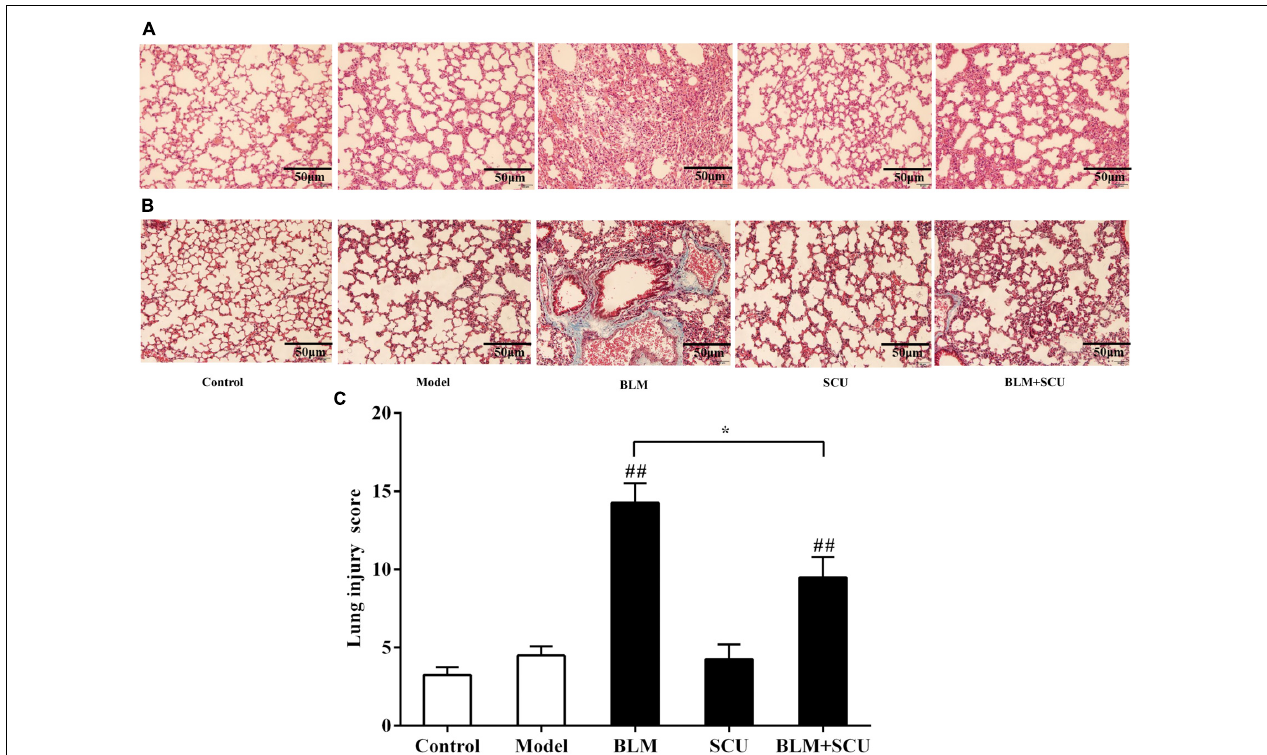
FIGURE 5 | Effects of SCU attenuated BLM-induced lung fibrosis. Lung tissue sections were stained with hematoxylin–eosin (HE) staining (A) for pathological observation ( × 200), with Masson (B) for collagen deposition ( × 200). (C) The lung injury scores; the slides were histopathological evaluated using a semi quantitative scoring method. (a) Interstitial inflammation (score: 0–4), (b) inflammatory cell infiltration (score: 0–4), (c) congestion (score: 0–4), and (d) edema (score: 0–4). The total lung injury score was calculated by adding up the individual scores of each category. Scale bar indicates 50 µ m. Data are shown as the mean ± SD. ( n = 4). ## p < 0.01 compared with model group; ∗ p < 0.05 compared with BLM group.